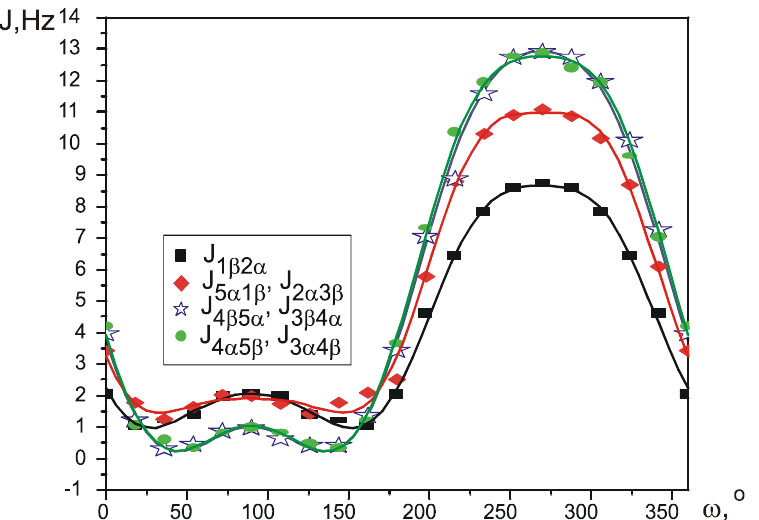
Figure 4. Pseudorotation angle dependency parameters for vicinal trans-SSCCs in trans-1,2- dichlorocyclopentane.